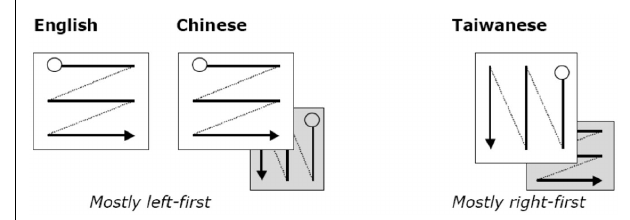
FIGURE 1 |Writing directions of English, Mainland Chinese, and Taiwanese. English is written exclusively from left to right, while Chinese in Mainland China is written primarily from left to right, with some texts still written top to bottom. InTaiwan, at the time when we collected data, in 2004, characters were predominantly written top to bottom, but there were at the time some left to right texts, and there are even more at